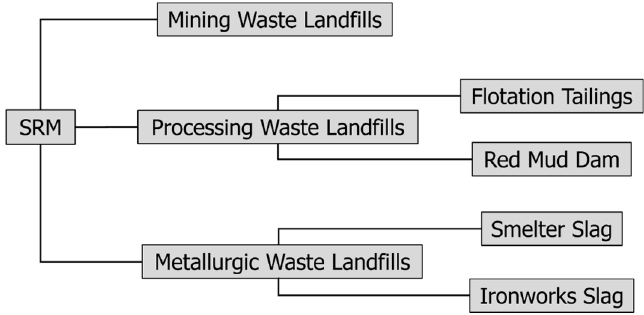
Figure 2. Types of mining, processing, and metallurgic waste.